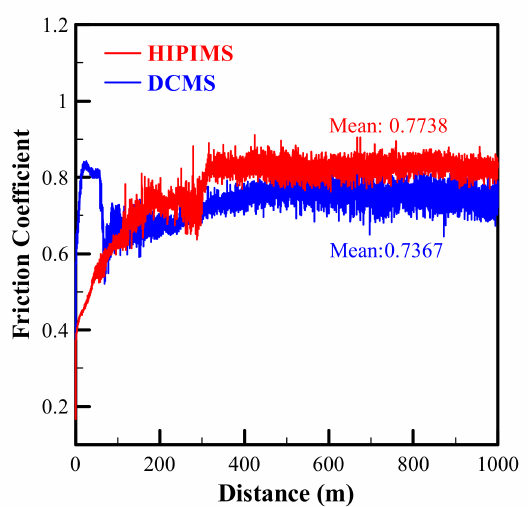
Figure 10. Variation of friction coe ffi cient with sliding distance for HiPIMS-TiN and DCMS-TiN coated HSS wear tested at 300 ◦